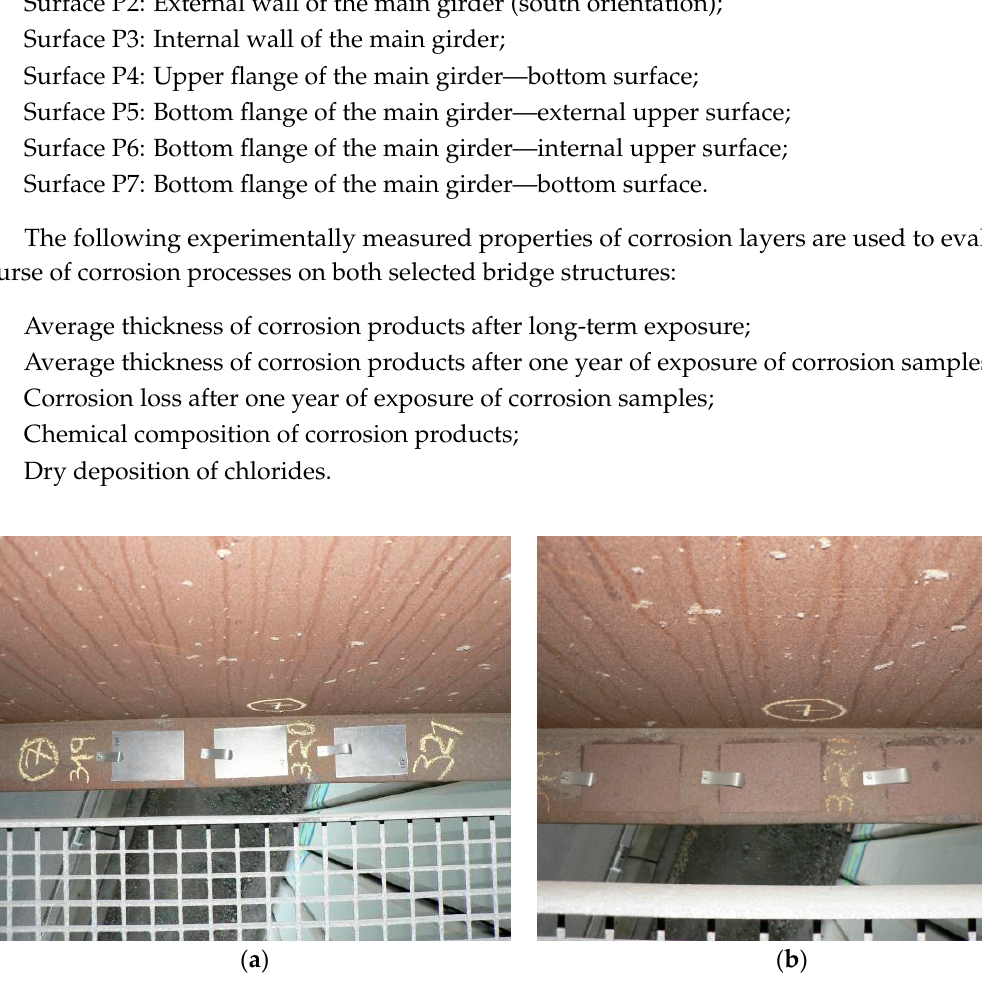
Figure 5. Corrosion samples on the upper surface of the bottom flange at the time of installation ( a ) and after 1 year of the exposure ( b ).